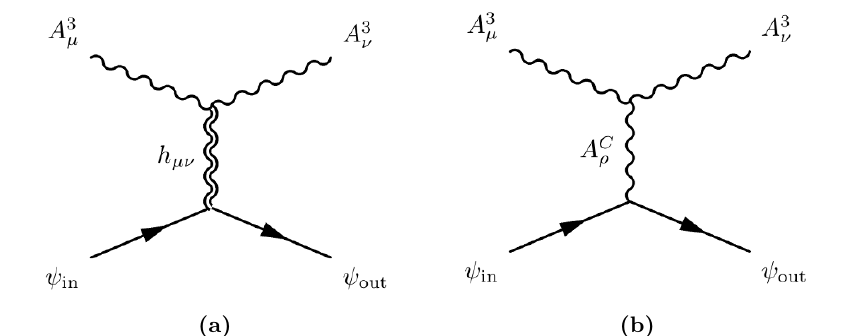
Figure 4. t -channel holographic dual representation of forward Compton scattering at